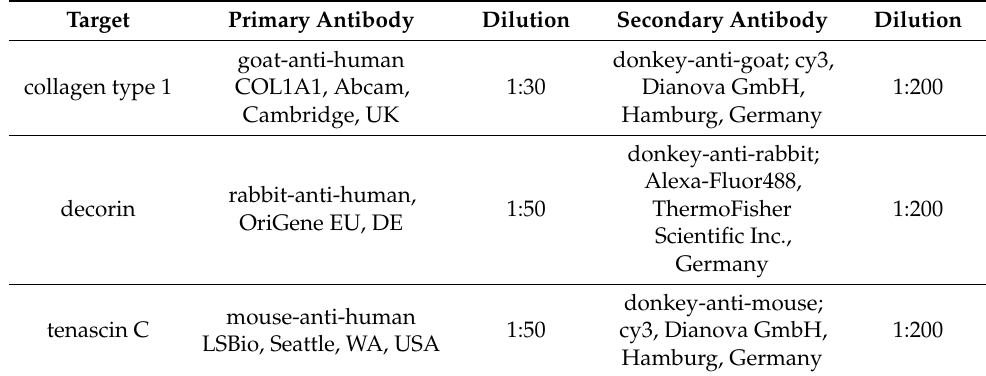
Table 3. Antibodies used to localize